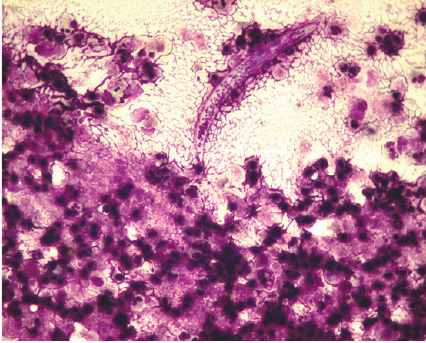
Figure 2: Fine needle aspiration cytology showing macrophages and nucleated squamous cells in a dense acute suppurative back- ground with degenerated